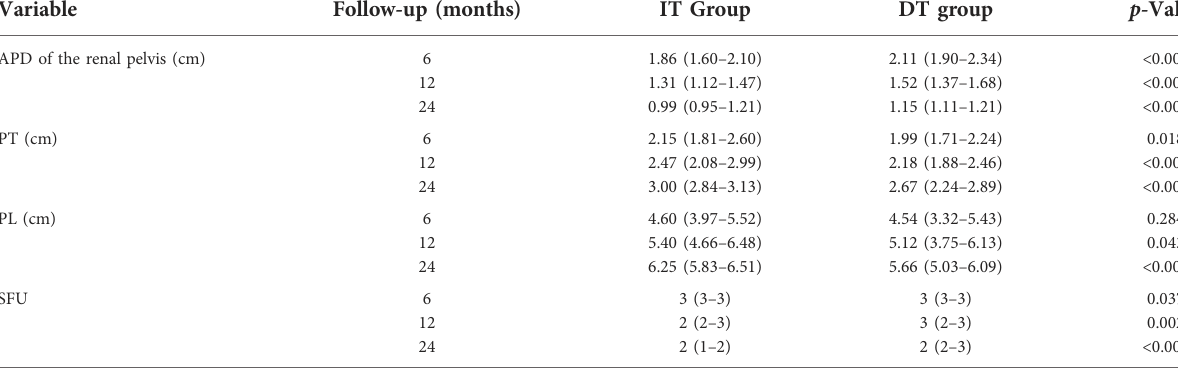
TABLE 3 Follow-up characteristics of hydronephrosis in infants. Variable Follow-up